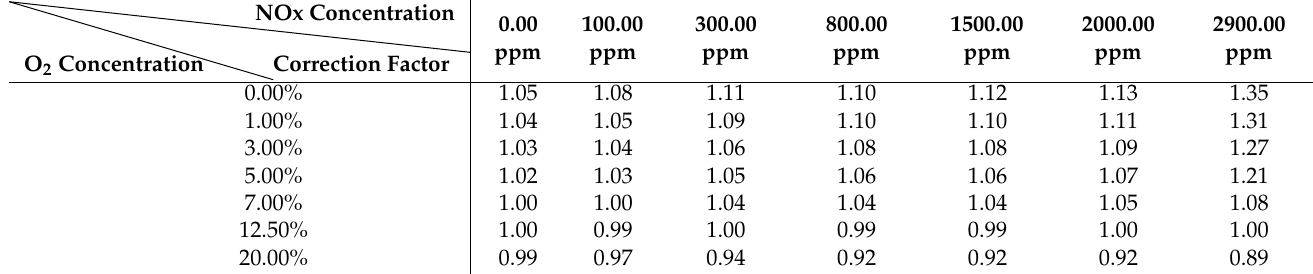
Table 4. The calibration parameters of the NOx sensor for oxygen concentration dependence.